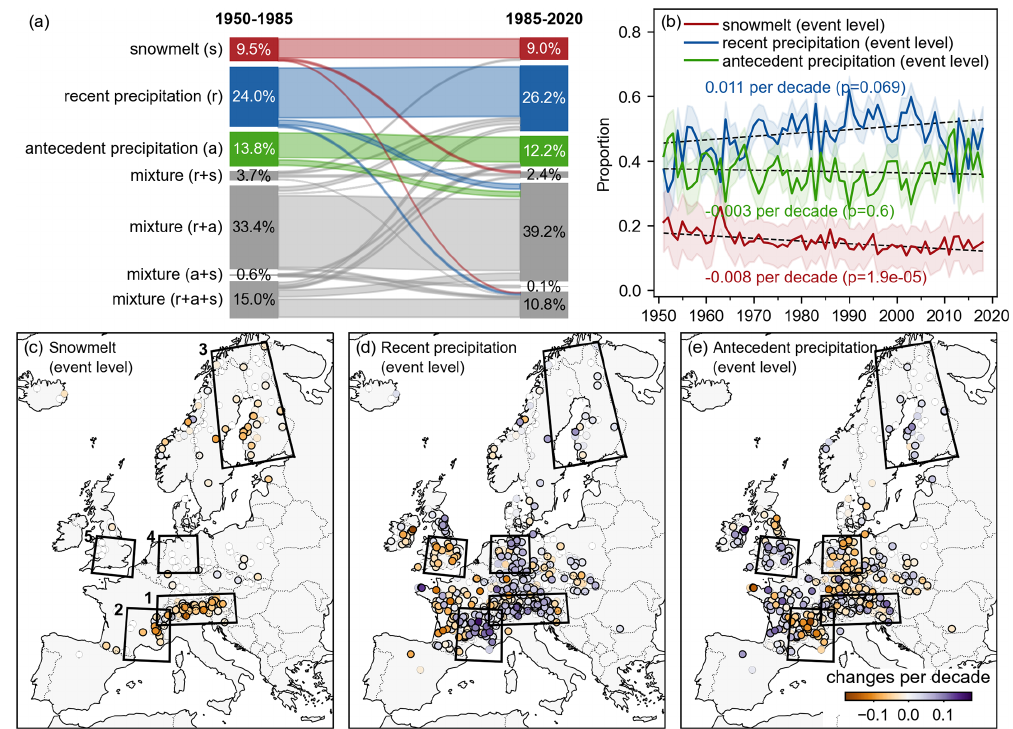
Figure 7. (a) Sankey plot indicating the proportions of single dominant flood-generating mechanisms and their combinations during two time periods, with the flow lines indicating shifts between them. The proportions were calculated based on the 818 catchments that have at least 15 years of records available in each period. (b) The evolution of the proportions of annual maximum peak discharges with the three flooding mechanisms. The shades denote the 95% confidence interval of the proportions, which was calculated as ˆ p ± 1 . 96 × ( ˆ p is the estimated proportion, and n is the sample size). The dashed black lines indicate the slope of their trends estimated by Theil– Sen’s estimator, with their significance being assessed by the modified Mann–Kendall test. (c–e) The spatial trends in different event-based flooding mechanisms, where the trends indicated by the colorful dots were calculated using a 20-year moving window. Markers with black edges denote catchments with significant trends ( α = 0 . 05). The black boxes highlight five hotspot regions that are discussed in the main